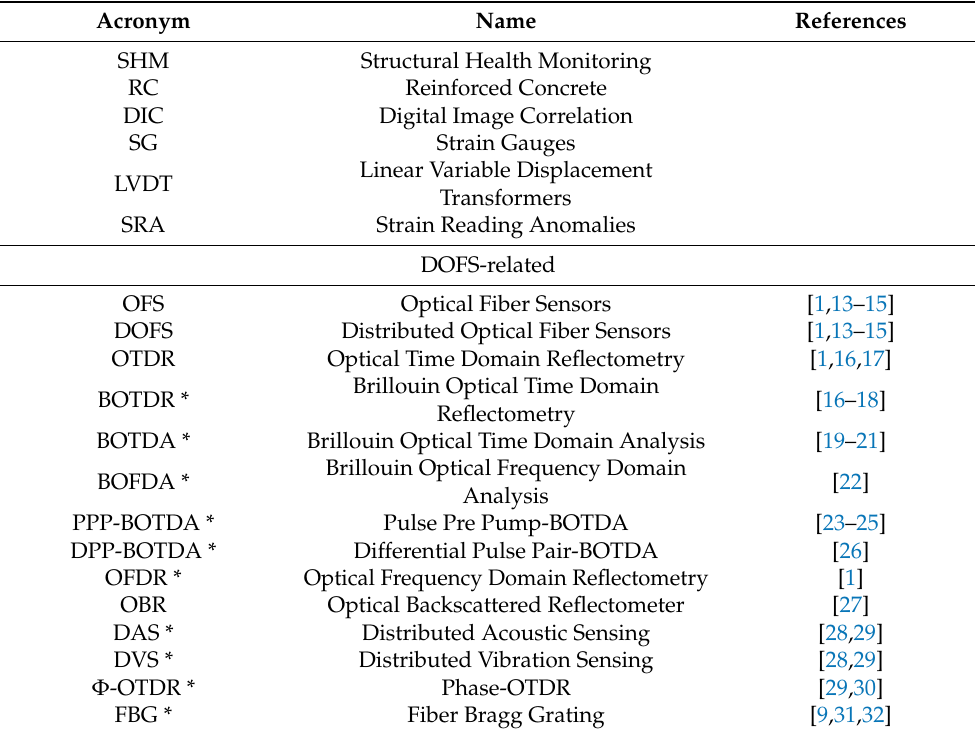
Table 1. Acronyms used in the present article and literature